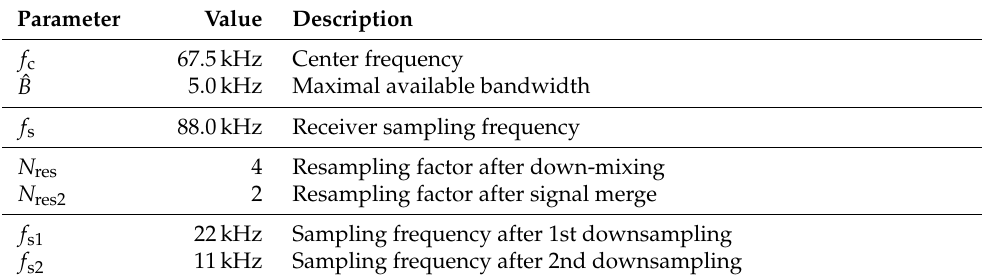
Table 1. Transmission Band